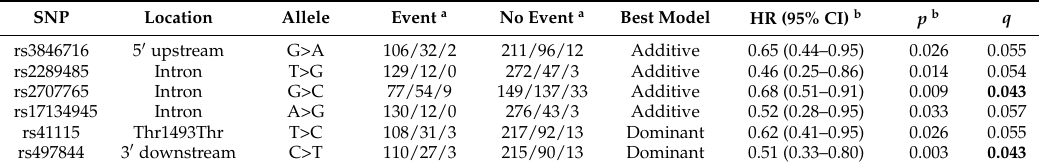
Table 2. Association between htSNPs in APC and ACM in prostate cancer patients treated with